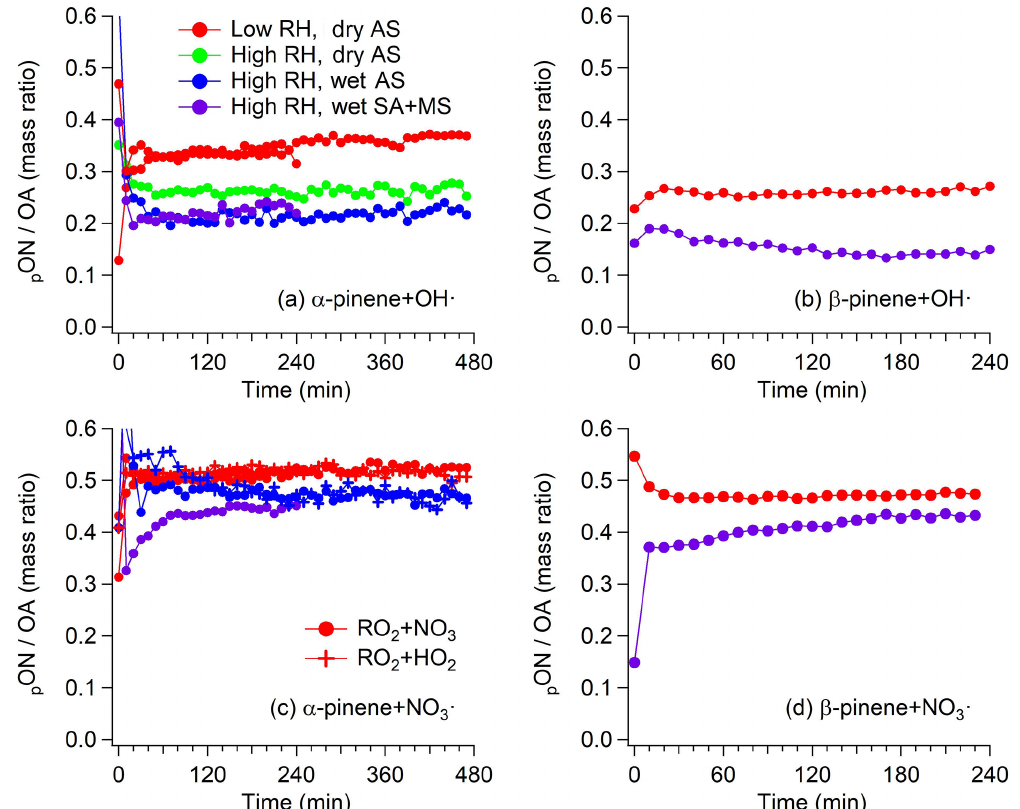
(cid:113) from Exps. 1–5, (b) β -pinene + OH (cid:113) from Exps. 14–15. Data points are colored by conditions concerning reactor RH and phase state (cid:113) , data points are also shaped differently depending on the expected dominant RO 2